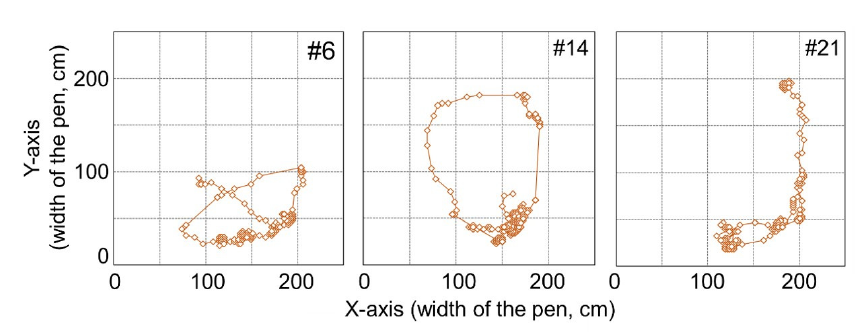
Figure 6. Tracking data of #6, #14 and #21